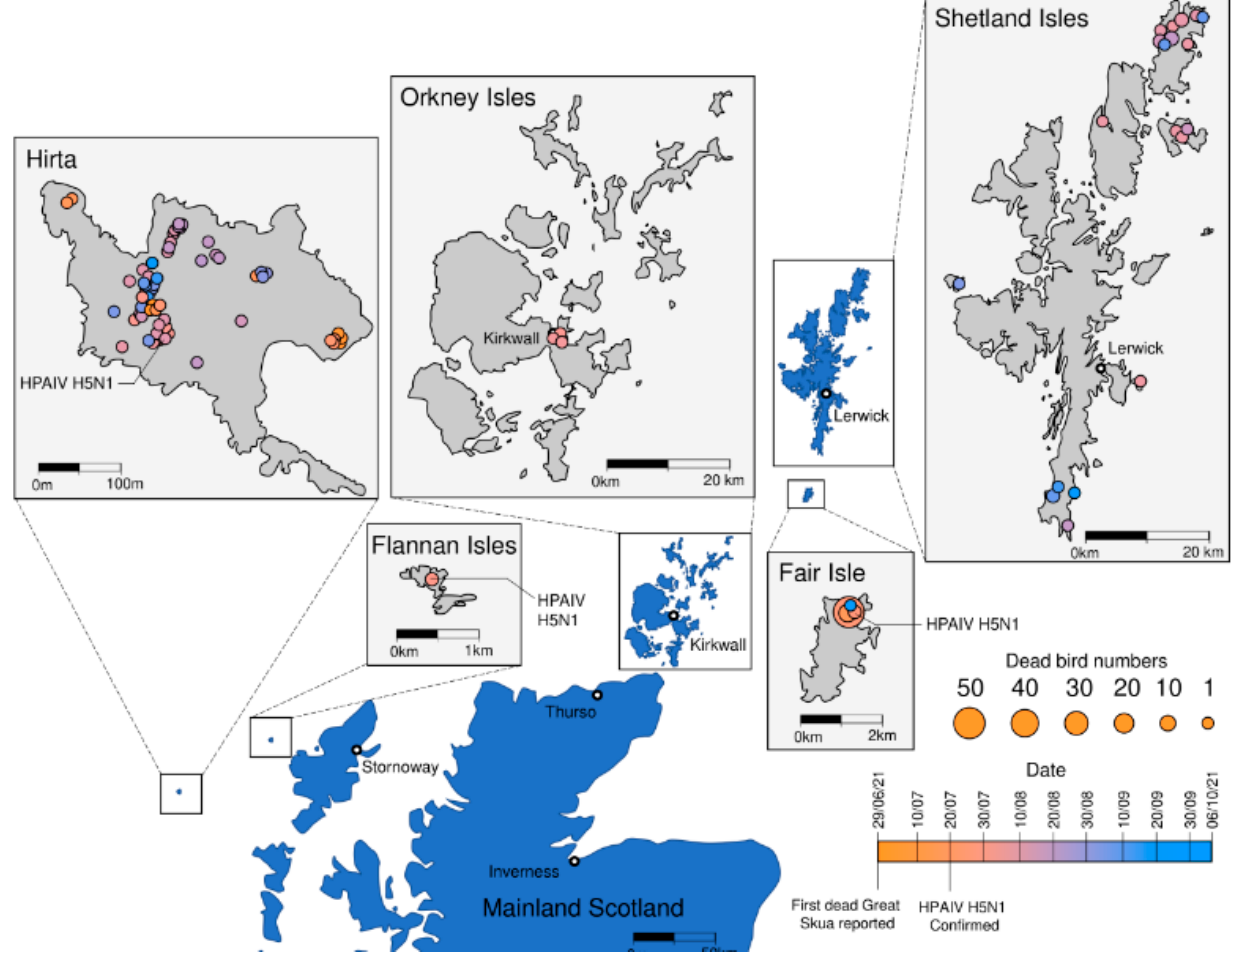
Figure 1. Geographical distribution of great skua carcasses and timeline of detection. The distribution of observed deaths is shown on the map for each island. Cases are coloured according to time of observation as denoted in the key. The size of circle is proportional to the number of cases with larger circles denoting a greater number of observed mortalities as per the key. Positive cases are also noted or each island.